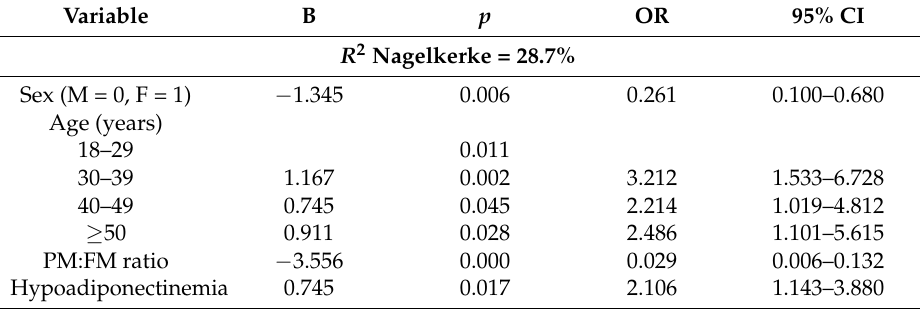
Table 3. Binary logistic regression model for the risk factors associated with the MUH phenotype.